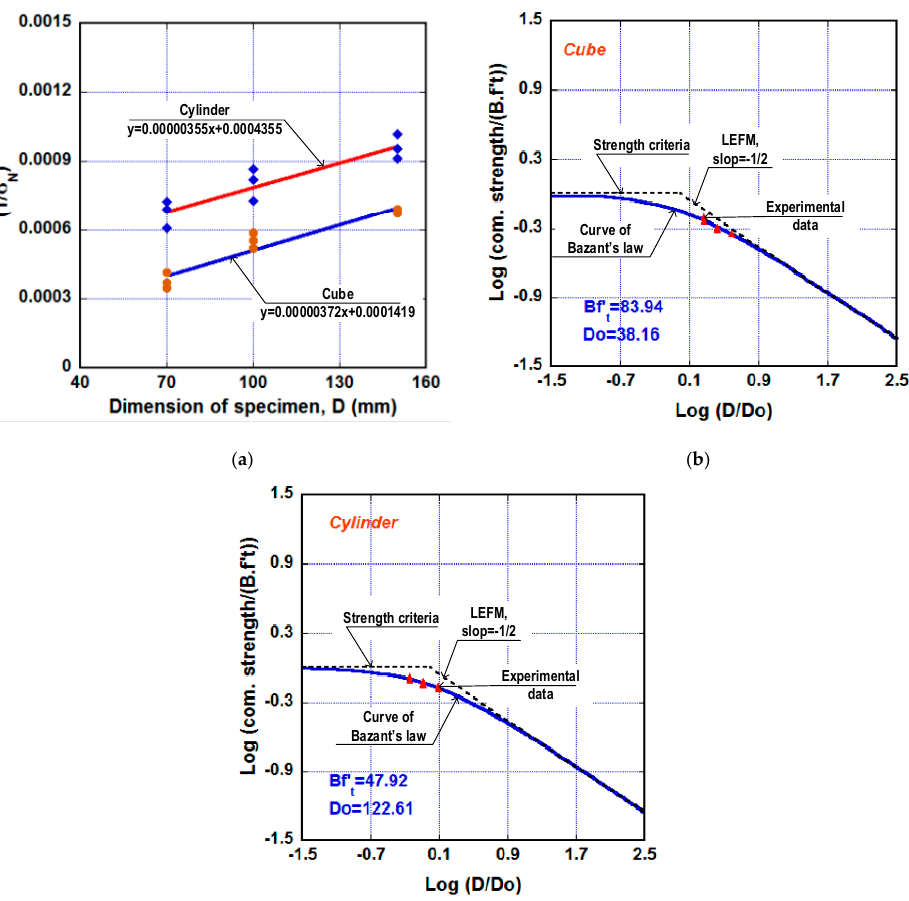
Figure 14. Applying Bažant’s size effect law for the steel-slag concrete. ( a ) Attaining of material parameters of Bažant’s size effect law. ( b ) Bažant’s size effect law for cube-shaped specimen. ( c ) Bažant’s size effect law for cylinder-shaped specimen.